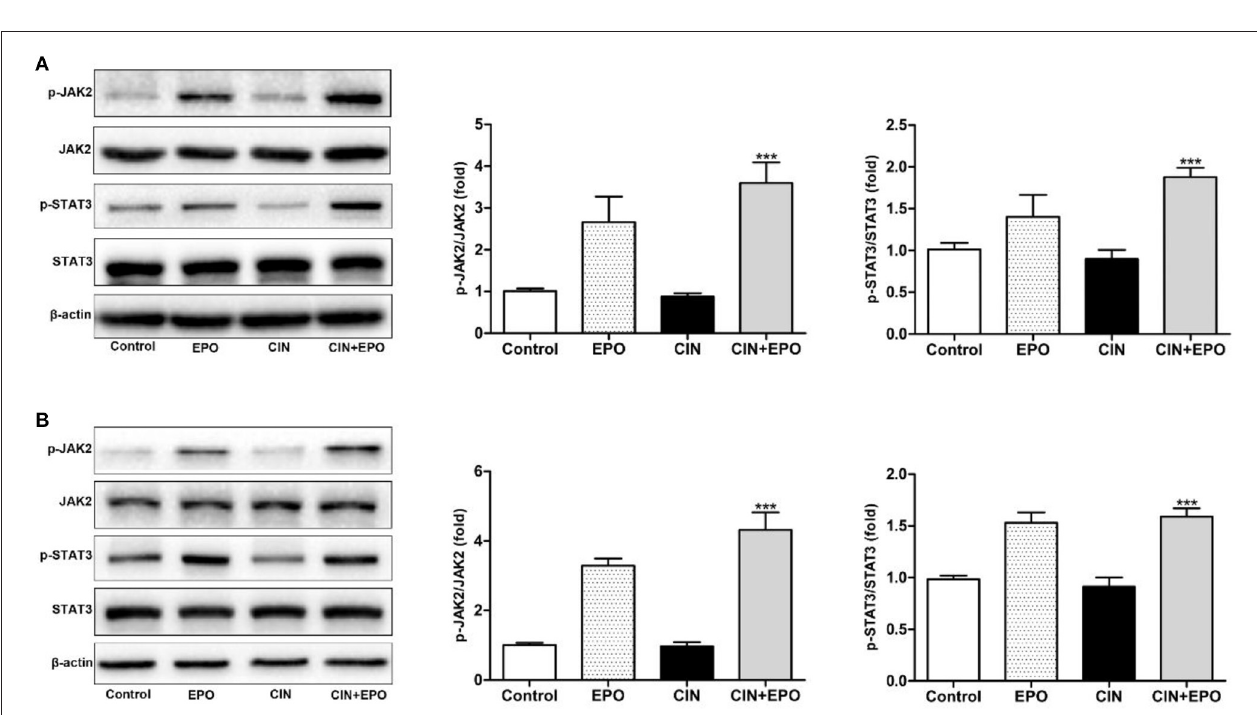
FIGURE 7 | Effect of EPO on protein levels of the JAK2/STAT3 signaling pathway components induced by contrast in mice (A) and HK-2 cells (B) . Values are expressed as the mean ± standard deviation ( n = 3). *** P < 0.001 vs. the CIN group. p-JAK2, phosphorylated Janus kinase 2; p-STAT3, phosphorylated signal transducer and activator of transcription 3; EPO, erythropoietin; CIN, contrast-induced